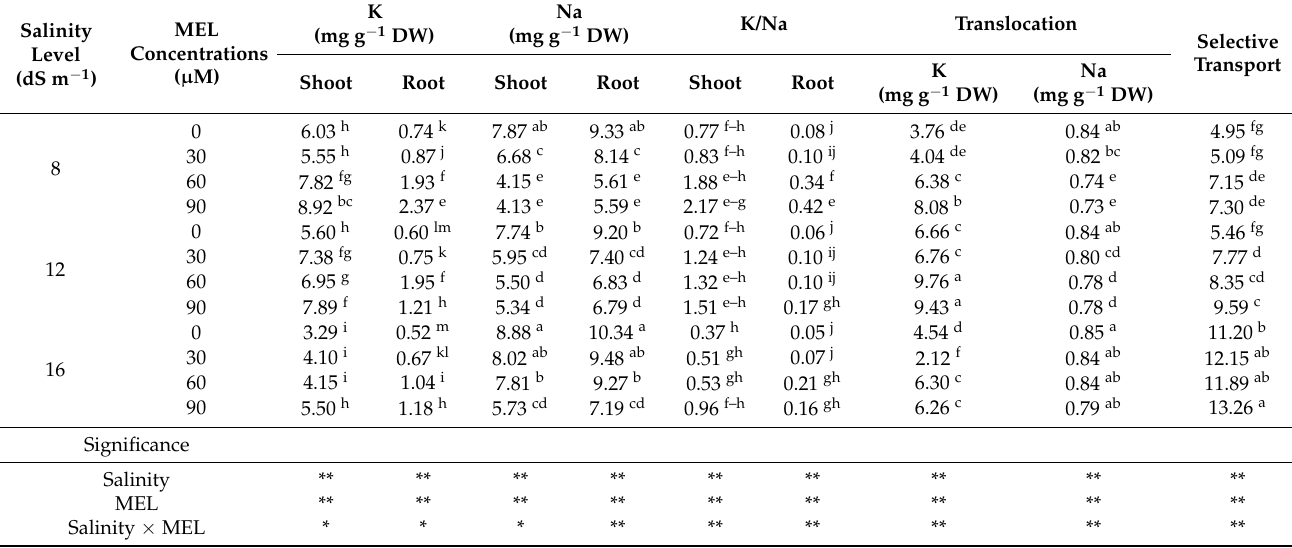
replicates per treatment.